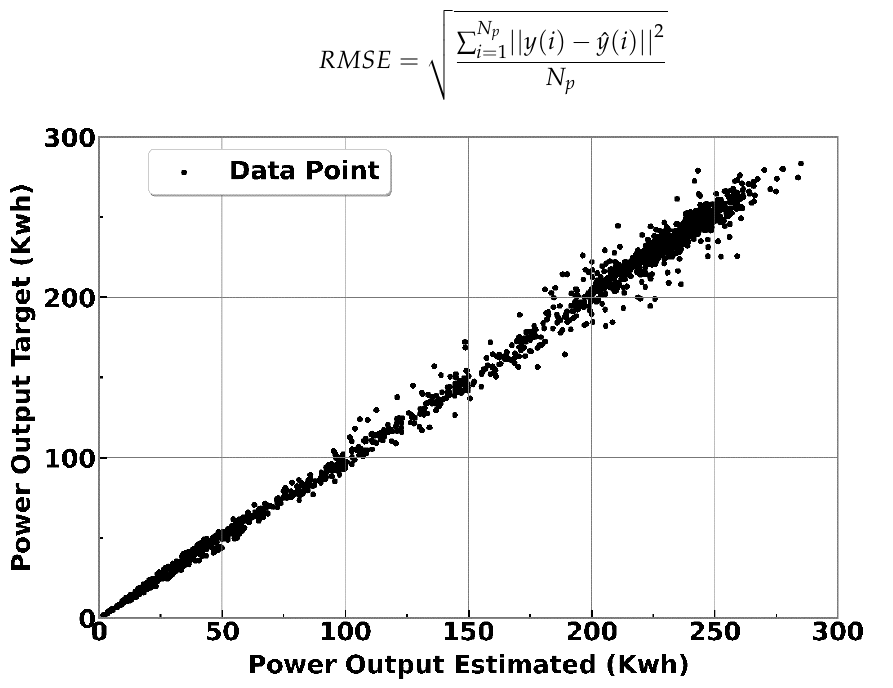
Figure 10. Performance of the neural network on training set.